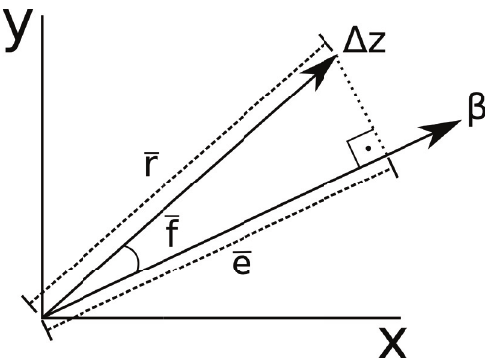
Figure 1. Graphical representation of evolvability ( e¯ ), respondability ( r¯ ) and flexibility ( f¯ ) for a single selection gradient ( β ) and the corresponding response ( Δ z ) in the two dimensions defined by traits x and y